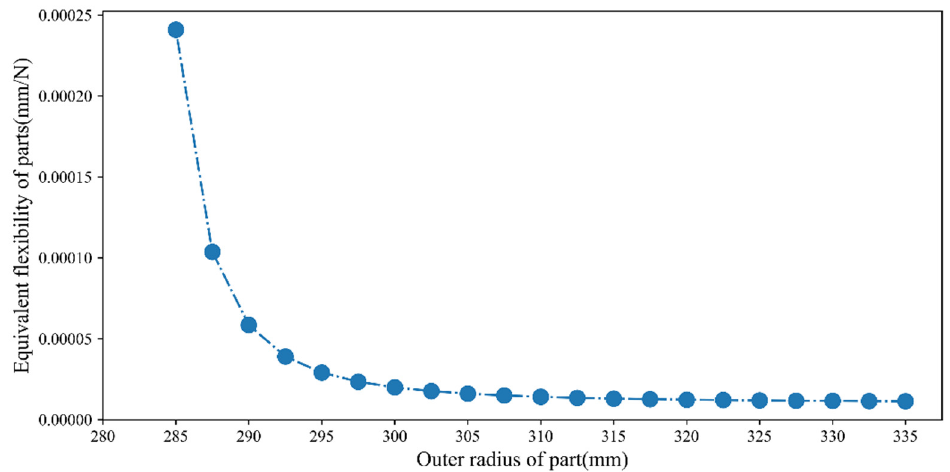
Figure 7. Relationship between the equivalent flexibility and the outer radius of the in-process work- piece.